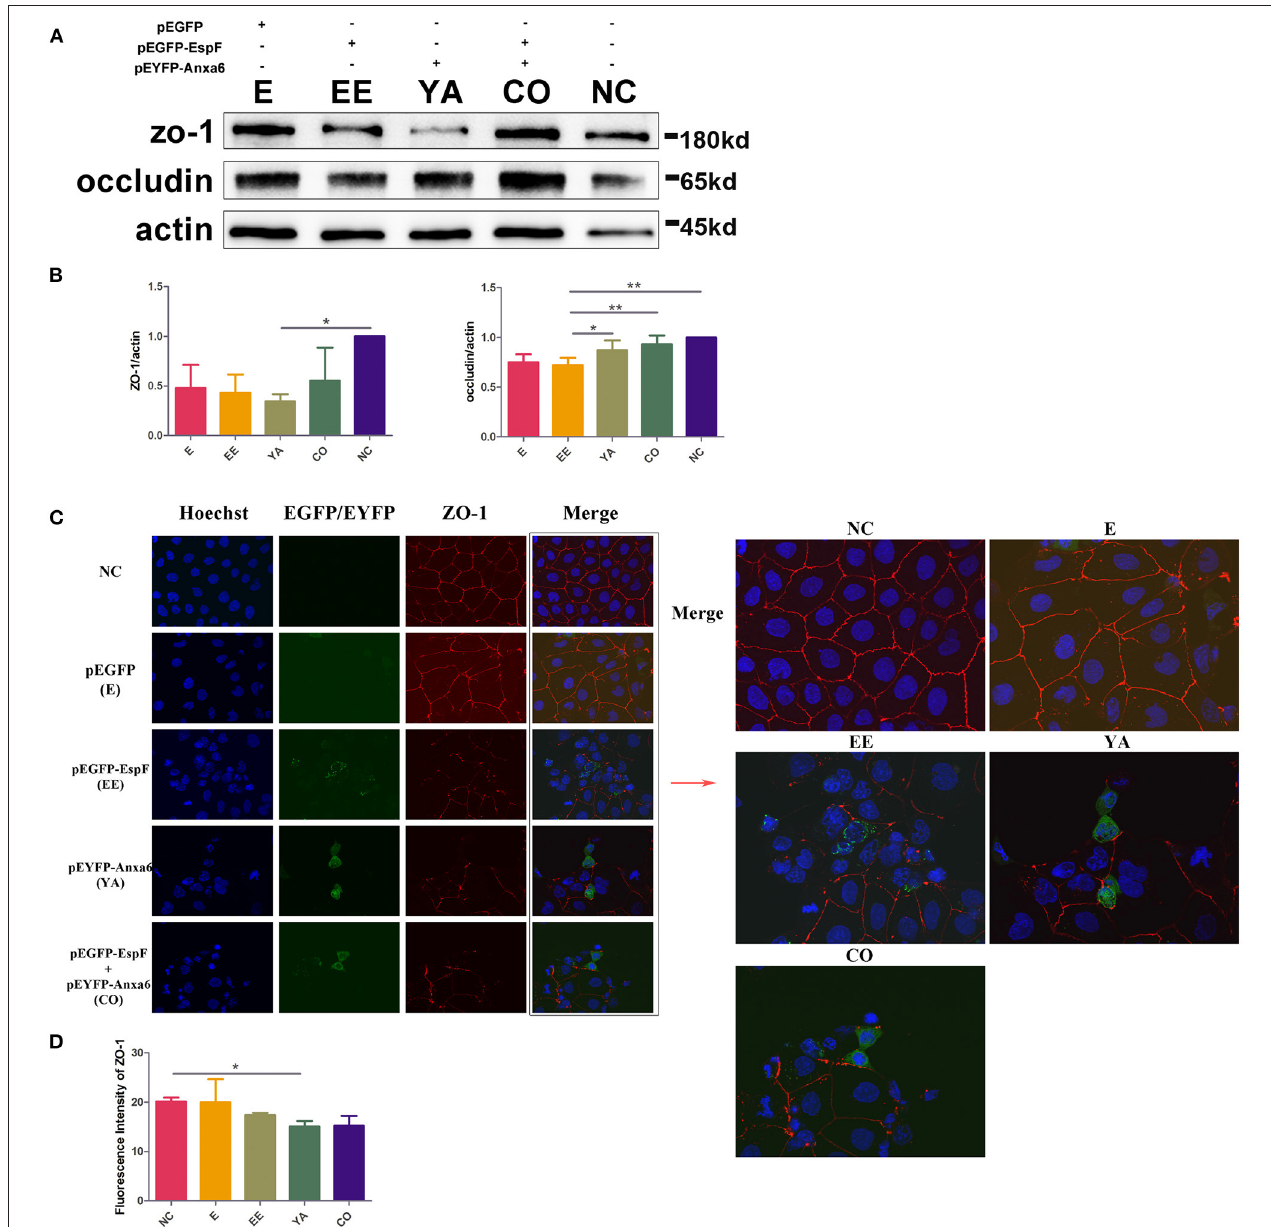
FIGURE 4 | Plasmid-encoded EspF and ANXA6 proteins decrease the expression levels of ZO-1 and occludin and disrupt the distribution of ZO-1 in transfected Caco-2 cells. (A,B) The expression levels and grayscale analysis of WB strips in Caco-2 cells transfected with plasmids as indicated. The grayscale analysis was performed by ImageJ software. Error bars represent means ± SD from three independent experiments. (C) Immunofluorescence microscopy of ZO-1 protein. The nucleus was labeled with Hoechst in blue. ZO-1 was labeled with anti-ZO-1 antibody in red. Green indicates fluorescence expressed by the fluorescent plasmid. Images were acquired on an FV1000 confocal laser scanning microscope using a 60X oil objective. (D) Quantification analysis of fluorescence intensity of ZO-1 by ImageJ software. Error bars represent means ± SD from three independent experiments. NC, non-transfected cells; E, cells transfected with Pegfp; EE, cells transfected with pEGFP-EspF; YA, cells transfected with pEYFP-Anxa6; CO, cells co-transfected with pEGFP-EspF and pEYFP-Anxa6. *Statistically significant difference. * p < 0.05. ** p <